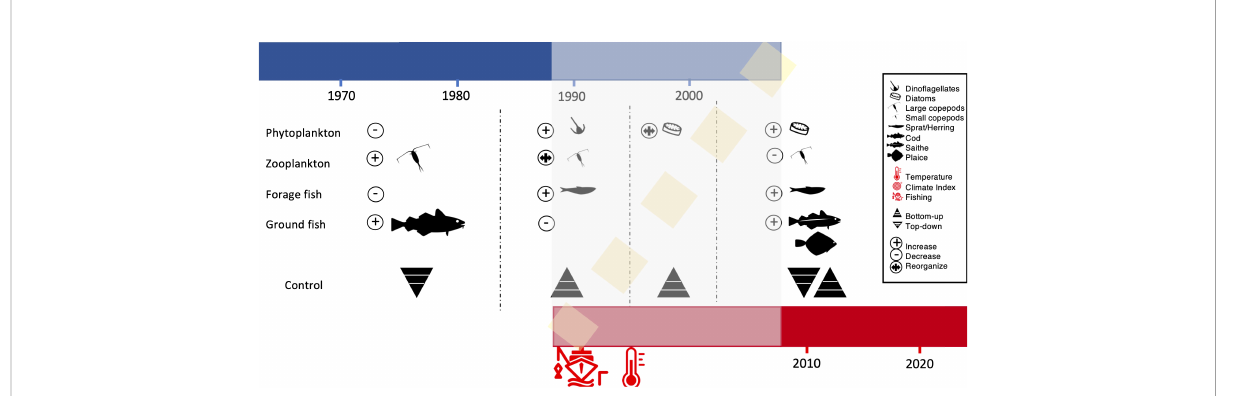
FIGURE 4 The North Sea regime shift. The 4 states of the North Sea community are indicated started from before the 1980s to after the 2003. In blue the fi rst part of the time series which was stable and in red the new irreversible state of the system. The fi rst 3 states are described in the literature, while the latter is for the fi rst time detected in our comprehensive analyses. The two main drivers of the regime shift, fi shing and climate change are indicated by the icons. The shaded area corresponds to the area of instability before a new stable state was reached, as indicated by our analysis. Icons in circles indicate whether a particular trophic level increased, declined or reorganized (in terms of relative species composition) in relation to a shift. Icons for organisms indicate regime-dominating species. Additionally, the food web control type (top-down or bottom-up) reported to be dominating during a speci fi c regime is